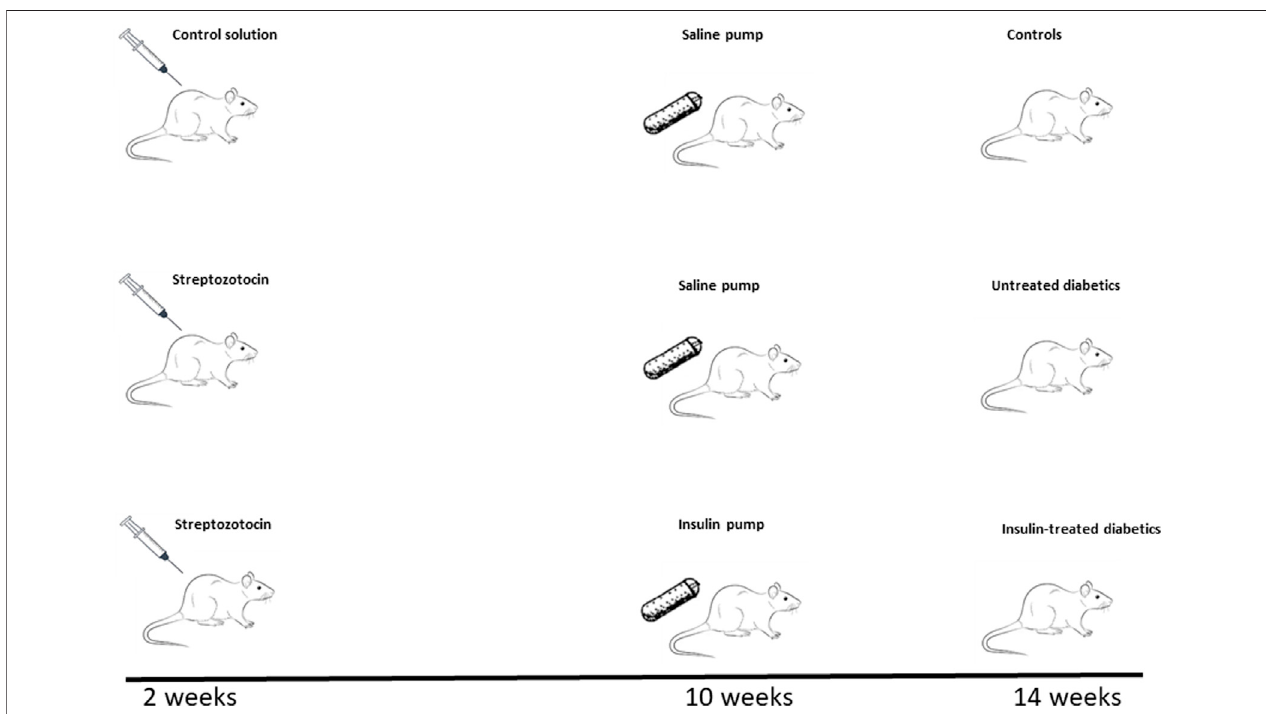
FIGURE 1 | Study Timeline. After being maintained on a regular diet for 2 weeks, 4 – 6-week-old male Wistar rats were divided into three groups: 2 groups were injected withStreptozotocin(65 mg/kg) toinduce diabetesand1group received acontrolsolution.Eight weeksafter theinduction ofdiabetes(10 weeksofstudytime), saline-deliveringpumpswereimplantedinthecontrolandoneofthediabeticgroups(untreateddiabetics,UDM),whileinsulin-deliveringpumpswereinstalledintheother diabetic group (insulin-treated diabetics, IDM). Therefore, at the end of the experiment at 14 weeks, three cohorts were inspected: controls (top panel), untreated diabetics (UDM, middle panel), and insulin-treated diabetics (IDM, bottom panel).